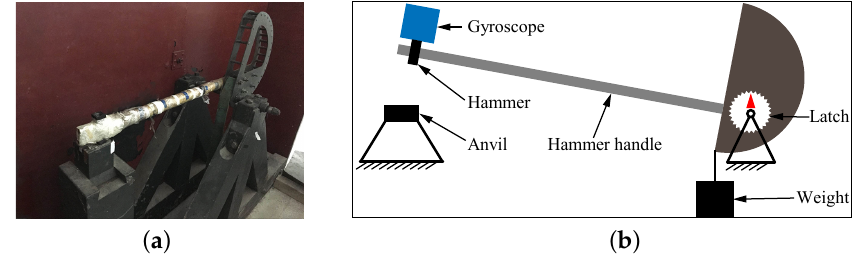
Figure 19. ( a ) Test device (machete hammer); ( b ) schematic for the dynamic experiment of the machete hammer.